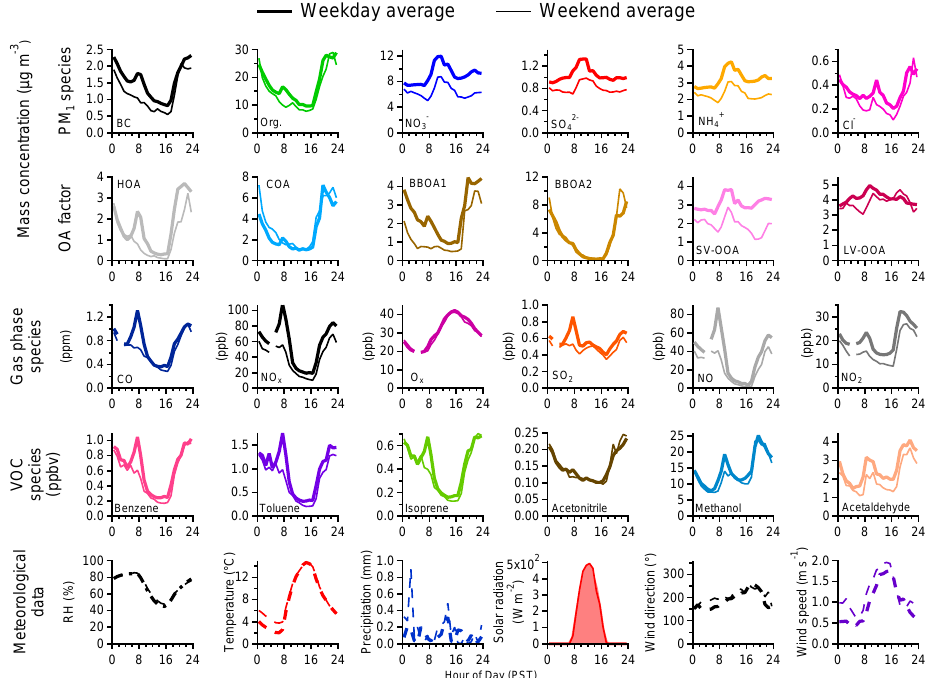
Figure 8. Average diurnal profiles for weekdays (Monday to Friday inclusive) and weekends (Saturday and Sunday) for the PM 1 species measured by the AMS and SP2 (top row), the six OA factors identified from PMF analysis (second row from the top), various gas-phase species from the CARB monitoring station (middle row), several VOCs measured by the PTR-MS (second row from the bottom), and various meteorological parameters (bottom row). The average diurnal profiles along with the standard deviations for all species for weekdays and weekends are shown in Fig.